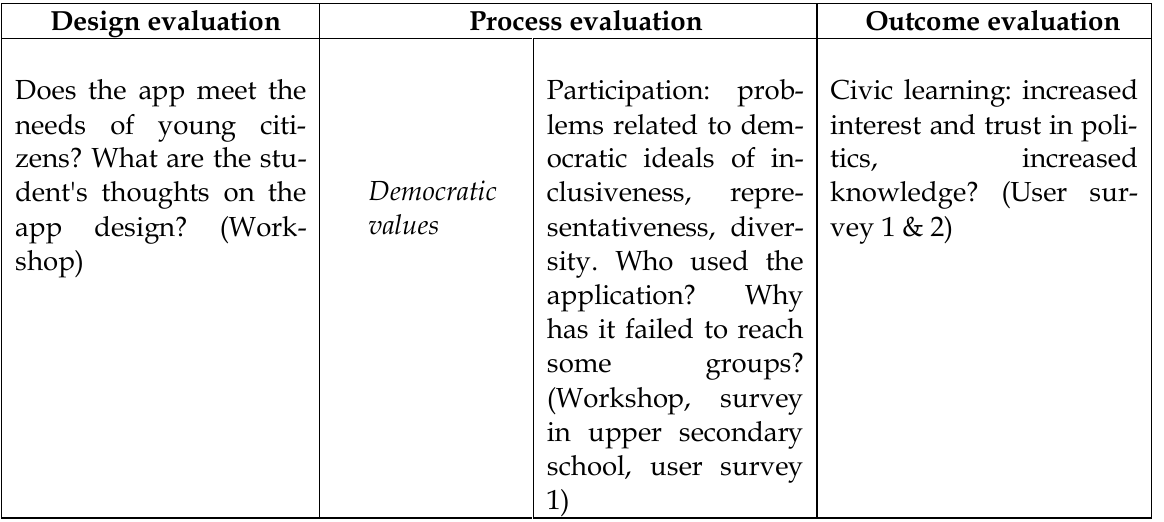
Table 2. The evaluation process in this